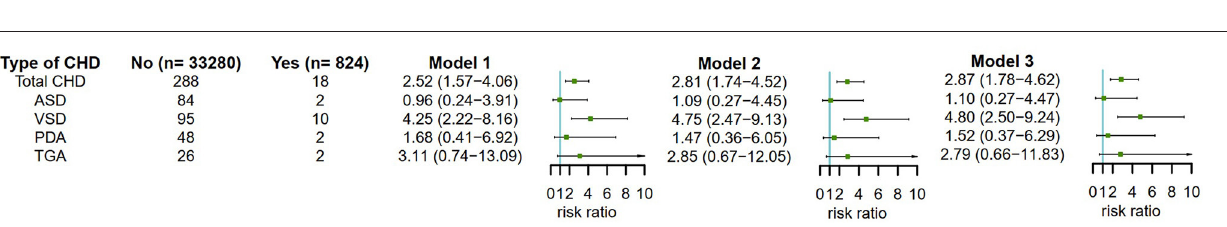
FIGURE 4 | Maternal antidepressant use in early pregnancy and risk of CHD and its phenotypes in offspring. Model 1 was a crude model without any variable adjusted. Model 2 adjusted for maternal age, ethnicity, residence location, education level, history of gestational diabetes mellitus, history of gestational hypertension, smoking before pregnancy, alcohol drinking before pregnancy and antidepressants use before pregnancy. Model 3 adjusted for maternal age, ethnicity, residence location, education level, history of gestational diabetes mellitus, history of gestational hypertension, smoking before pregnancy, alcohol drinking before pregnancy, antidepressants use before pregnancy, smoking in early pregnancy and alcohol drinking in early pregnancy. CHD, congenital heart disease.